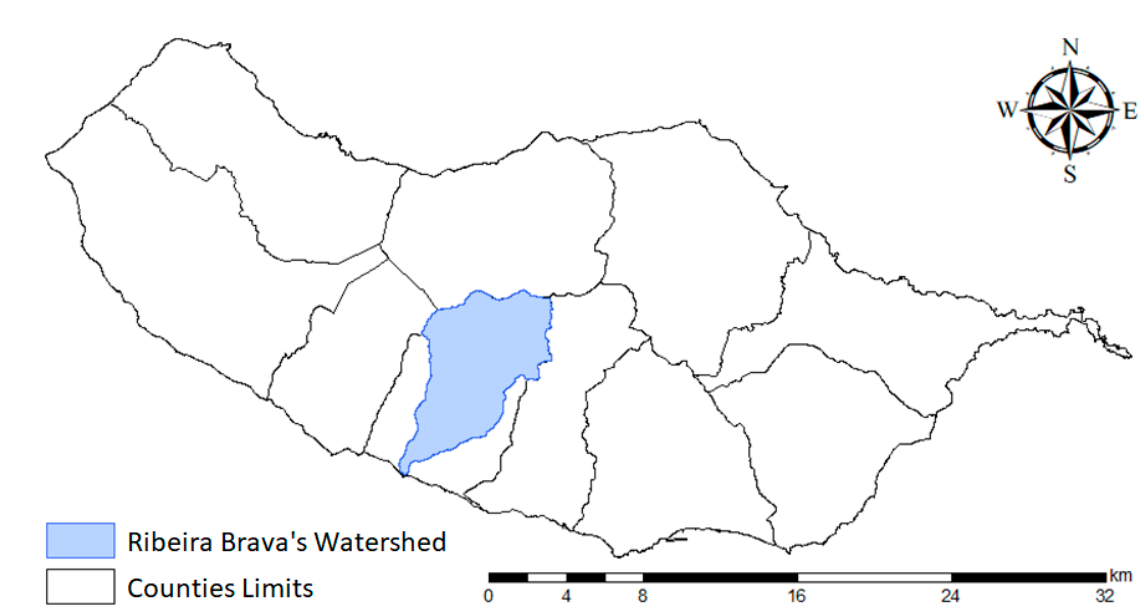
Figure 1. The Ribeira Brava watershed. (Source: Authors by ESRI ArcGIS, 2020).